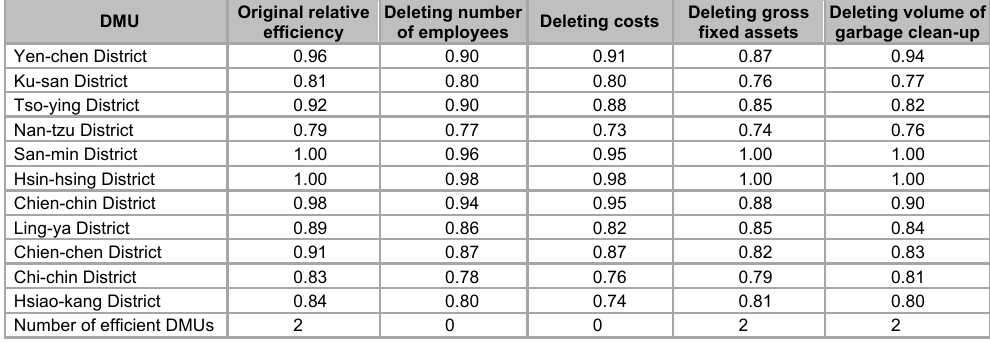
Sensitivity analysis of the deletion of single input and output items Deleting number DMU Original relative efficiency of